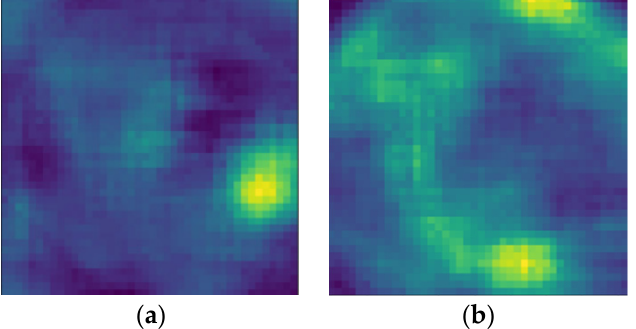
Figure 4. Heatmaps M k generated with sliding windows. ( a ) is an ideal heatmap with a single peak; ( b ) is a heatmap with multiple peaks.